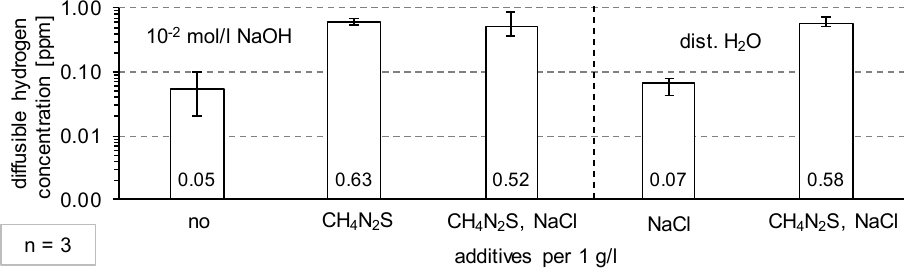
Figure 7. Influence of NaCl and CH 4 N 2 S content on hydrogen absorption at a current density of 100 mA/dm 2 .